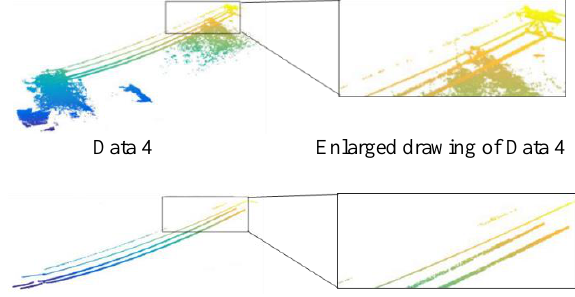
Figure 14. Partial enlarged drawing for Data 4 and its